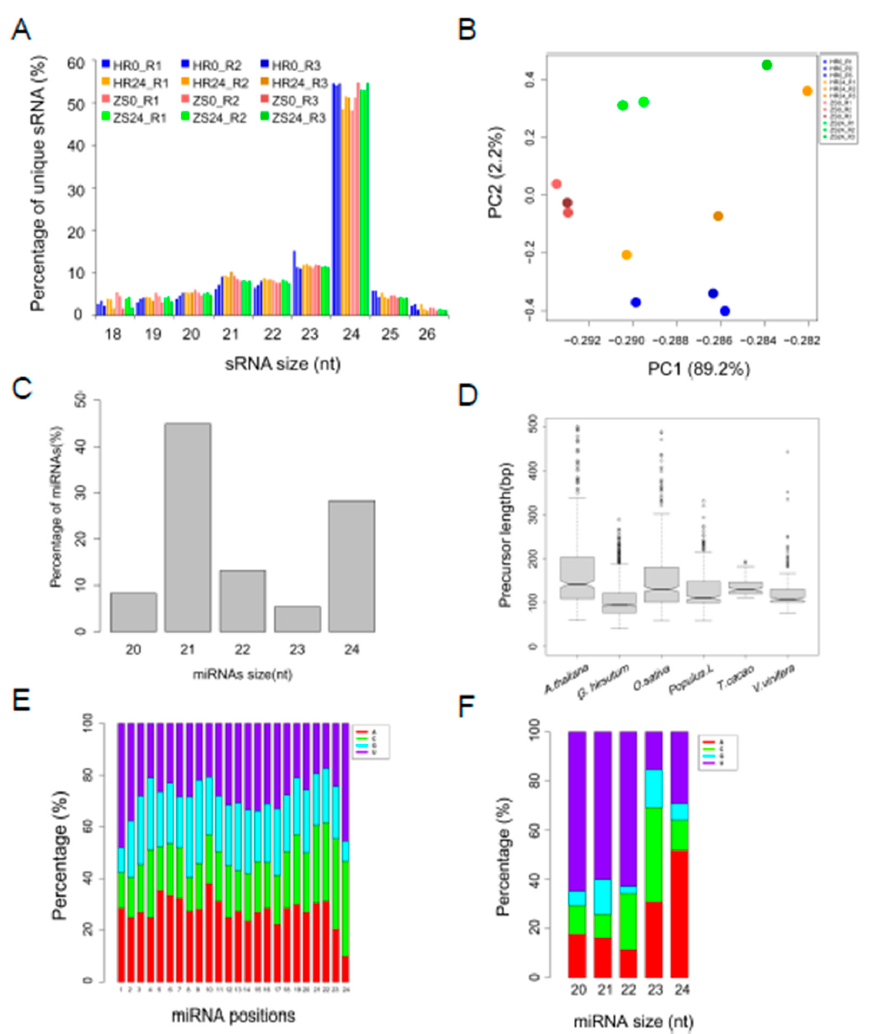
Figure 1. Identification and characterization of cotton miRNAs after whitefly infestation. ( A ) Distribution of unique sRNA length present in the three biological replicates. ( B ) Principle component analysis (PCA) of common sRNAs RPM from the twelve libraries. ( C ) Distribution of miRNA length. ( D ) Distribution of miRNA precursor length in cotton compared to four representative plant species. ( E ) Nucleotide preference at each position of the predicted miRNA. ( F ) Analysis of first nucleotide bias in the different miRNAs.